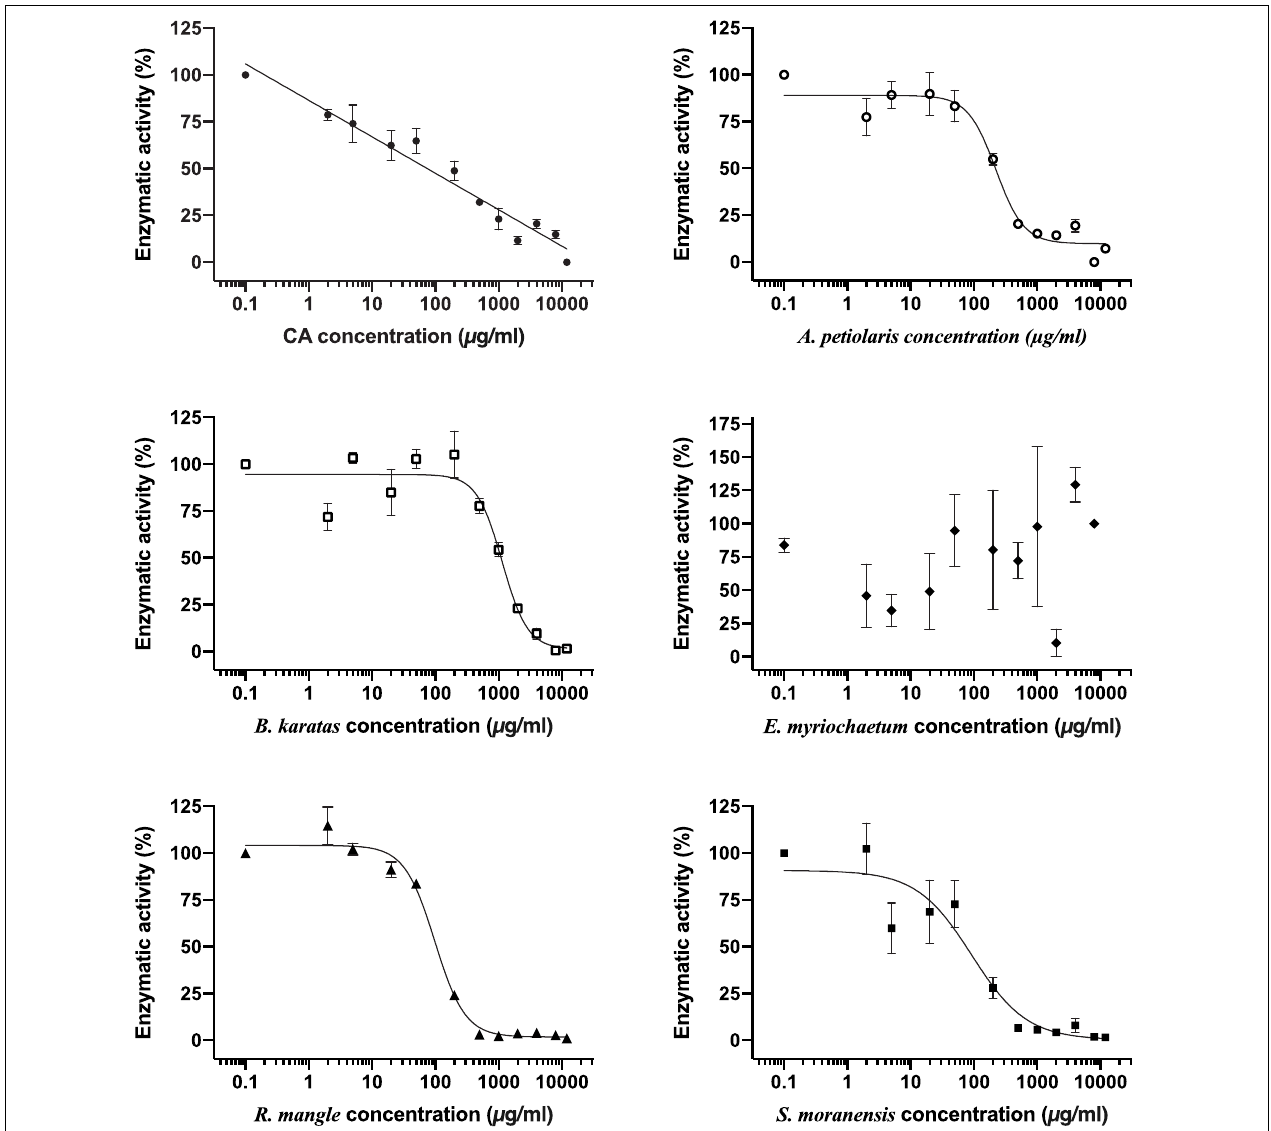
FIGURE 2 | Comparison of inhibitory concentration-response curves of chlorogenic acid and each plant extract on G6Pase system activity. Each point represents the mean of three replicates ± SEM. CA, chlorogenic